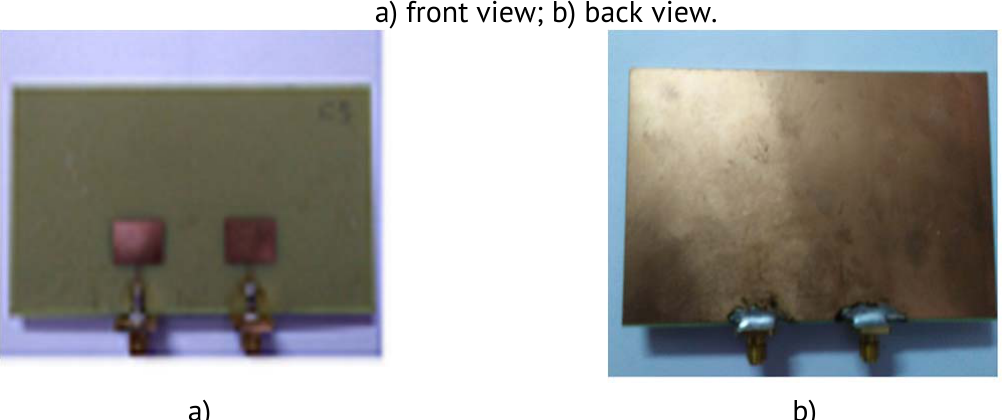
Figure 7. Photograph of conventional microstrip antenna array: